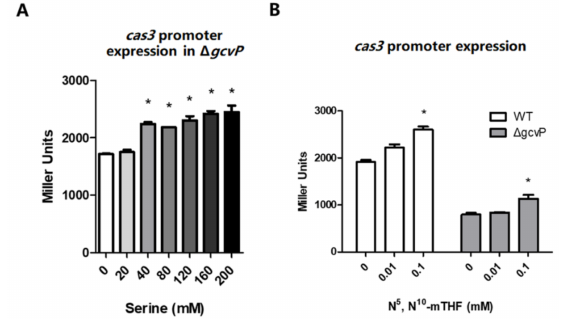
Figure 4. Serine and N 5 , N 10 -mTHF influence cas3 promoter activity. ( A ) The β -gal activity of the cas3 promoter was measured by reporter plasmids in ∆ gcvP cultured in LB media supplemented with 0, 20, 40, 80, 160, or 200 mM serine. The cas3 promoter was activated by 40 mM serine in ∆ gcvP in LB media ( B ) The β -gal activity of the cas3 promoter was measured by reporter plasmids in WT or ∆ gcvP cultured in minimal media supplemented with 0, 0.01, or 0.1 mM N 5 , N 10 -mTHF. 0.1 mM N 5 , N 10 -mTHF promoted cas3 promoter activity in both WT and ∆ gcvP. All the data were the mean ± SEM of at least three replicates, and the p value (* p < 0.05) was analyzed by the t